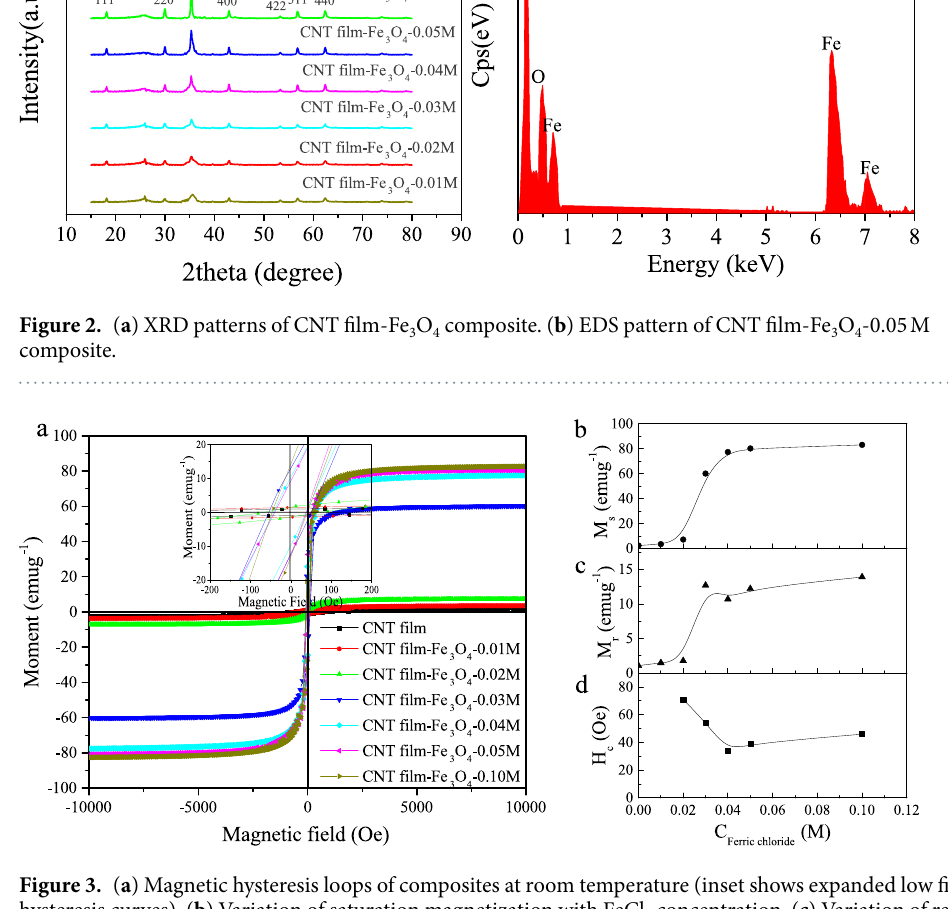
Figure 3. ( a ) Magnetic hysteresis loops of composites at room temperature (inset shows expanded low field hysteresis curves). ( b ) Variation of saturation magnetization with FeCl 3 concentration. ( c ) Variation of remnant magnetization with FeCl 3 concentration. ( d ) Variation of coercivity with FeCl 3